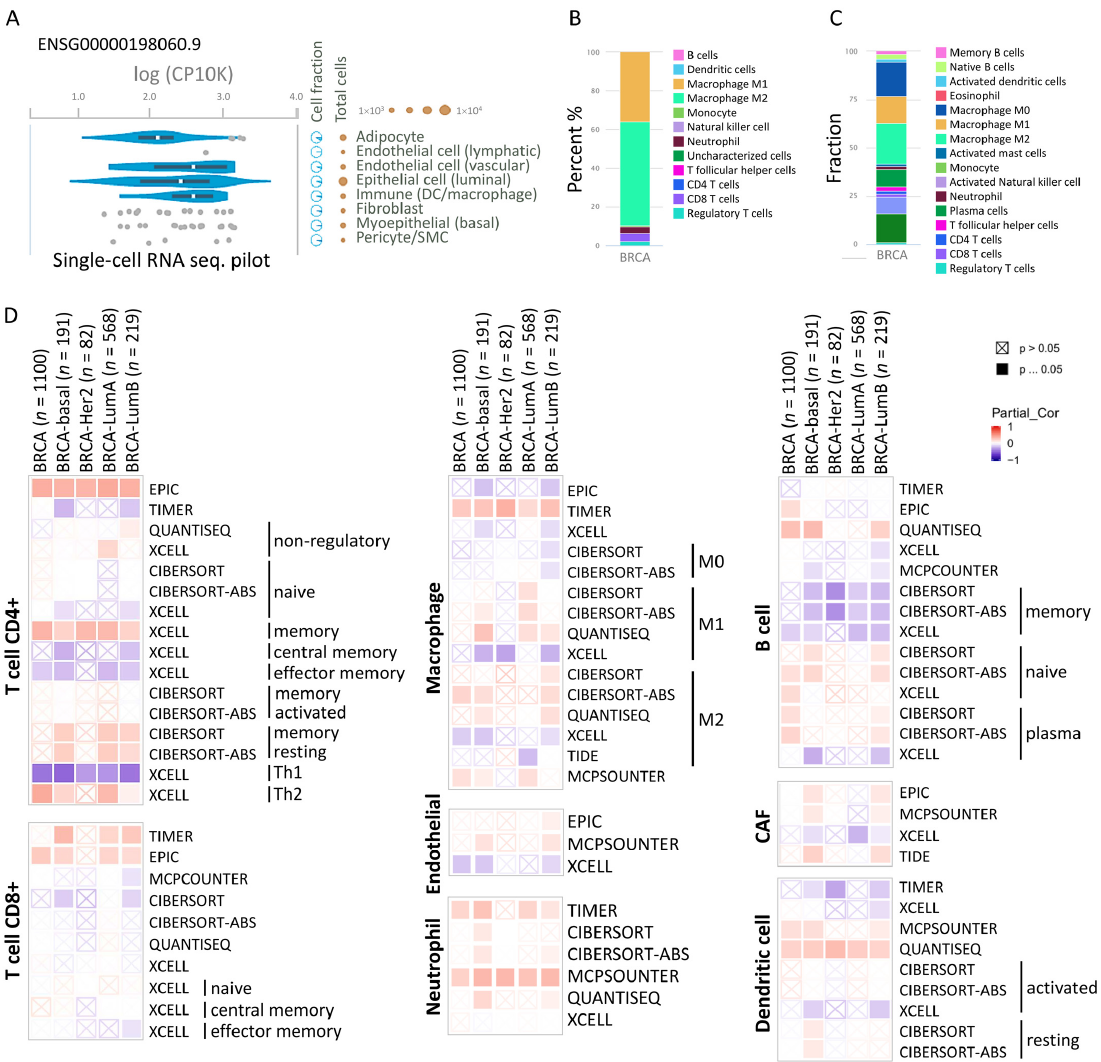
Figure 8. The correlation between MARCH5 and immunization. ( A ) RNA expression in single-cell clusters of breast cancer by immune marker genes in individual cells by bar graphs. ( B , C ) Immune cell percentage and fractionation bars showing the expression of the MARCH5 gene and well-known cell type markers in different clusters of single-cell types in tissues. ( D ) Heatmap showing the correlation between MARCH5 expression and immune infiltration in different breast cancer types. Different algorithms explored the potential correlations in MARCH5 expression level and T cell CD4 + , T cell CD8 + , macrophage, endothelial, neutrophil, B cell, dendritic cell, and cancer-associated fibroblasts (CAF) across types of BRCA in TCGA.